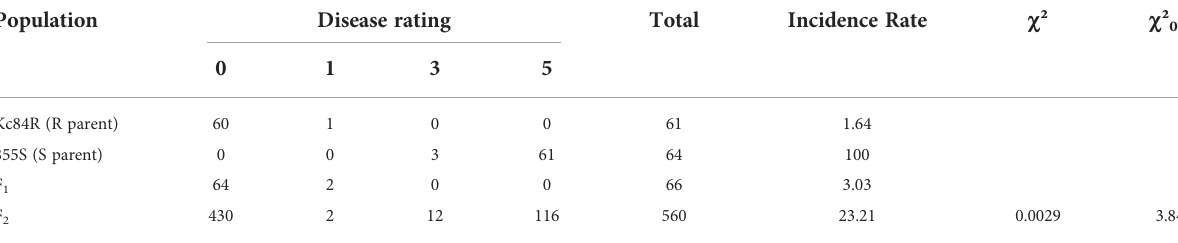
TABLE 2 Disease phenotype statistics in F 1 population from cross of Kc84R and 855S. Population